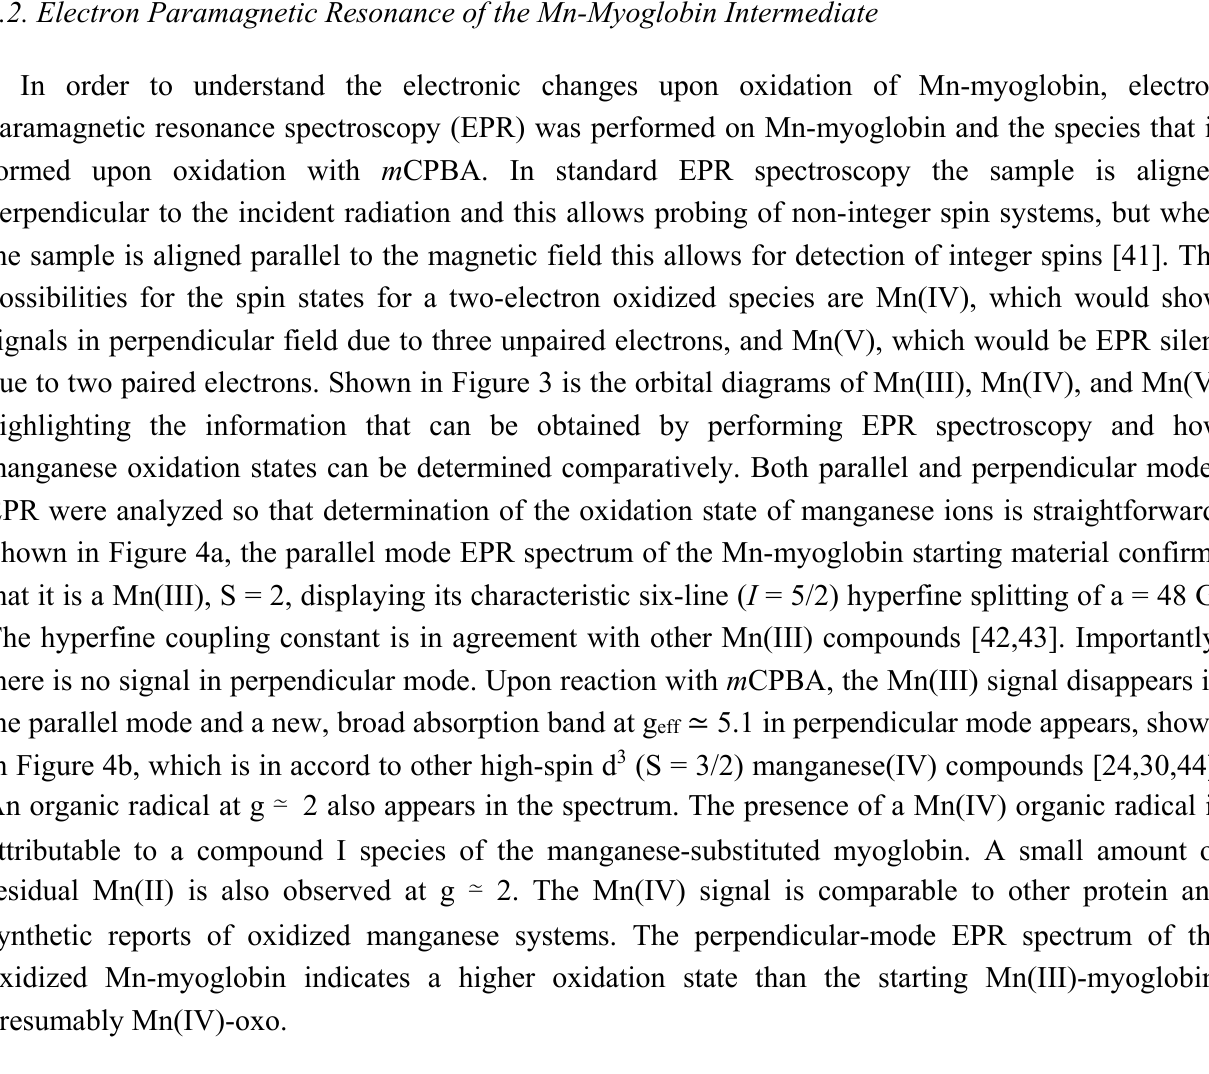
Figure 2: UV/vis absorption spectra of Mn(III)-myoglobin (black) and upon addition of m CPBA